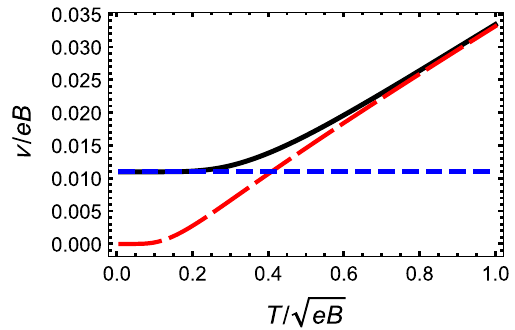
√ √ | eB | η = eB for fixed